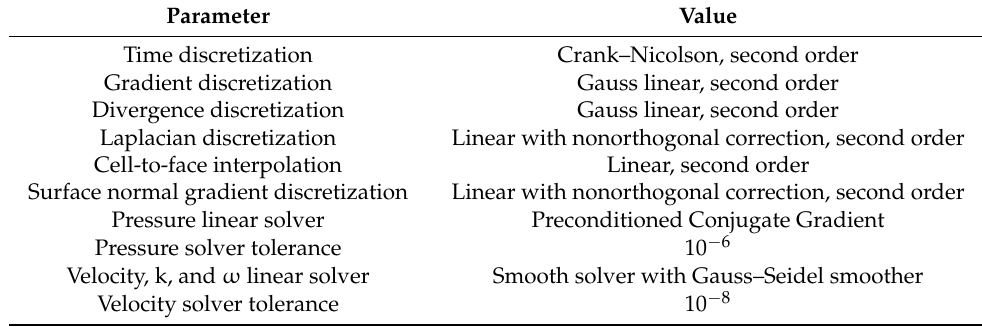
Table 2. Numerical settings used.